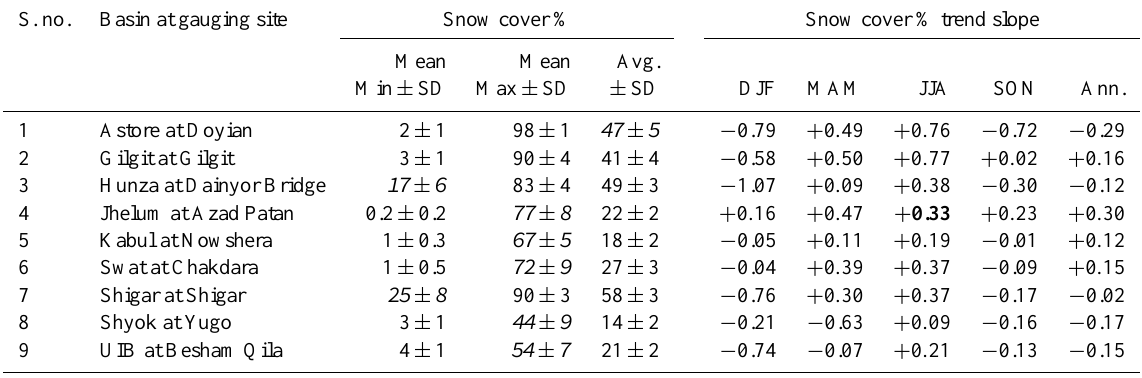
Table 6. List of nine basins with total areas along with snow coverage (SC) % and trend slopes (2001–2012). Values in bold are statistically significant; values in italic show a variability greater than or equal to 5%. S. no.